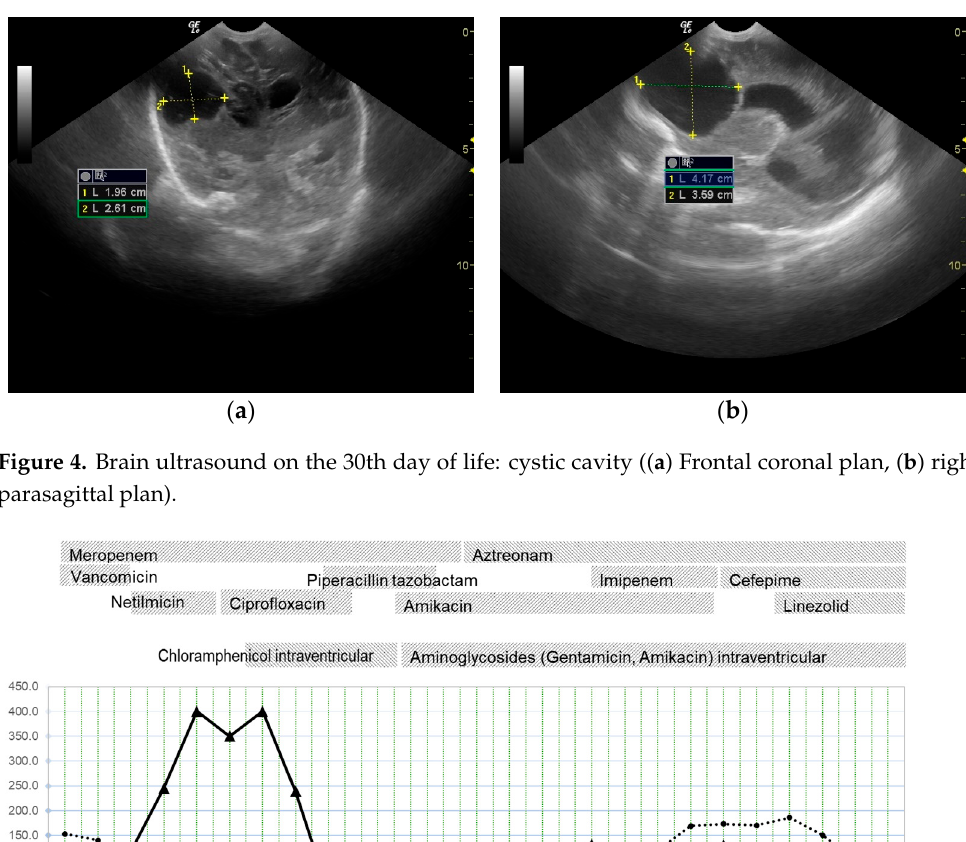
Figure 5. Evolution of the blood tests during hospitalization. CRP—C-reactive protein, PLT—number of platelets.